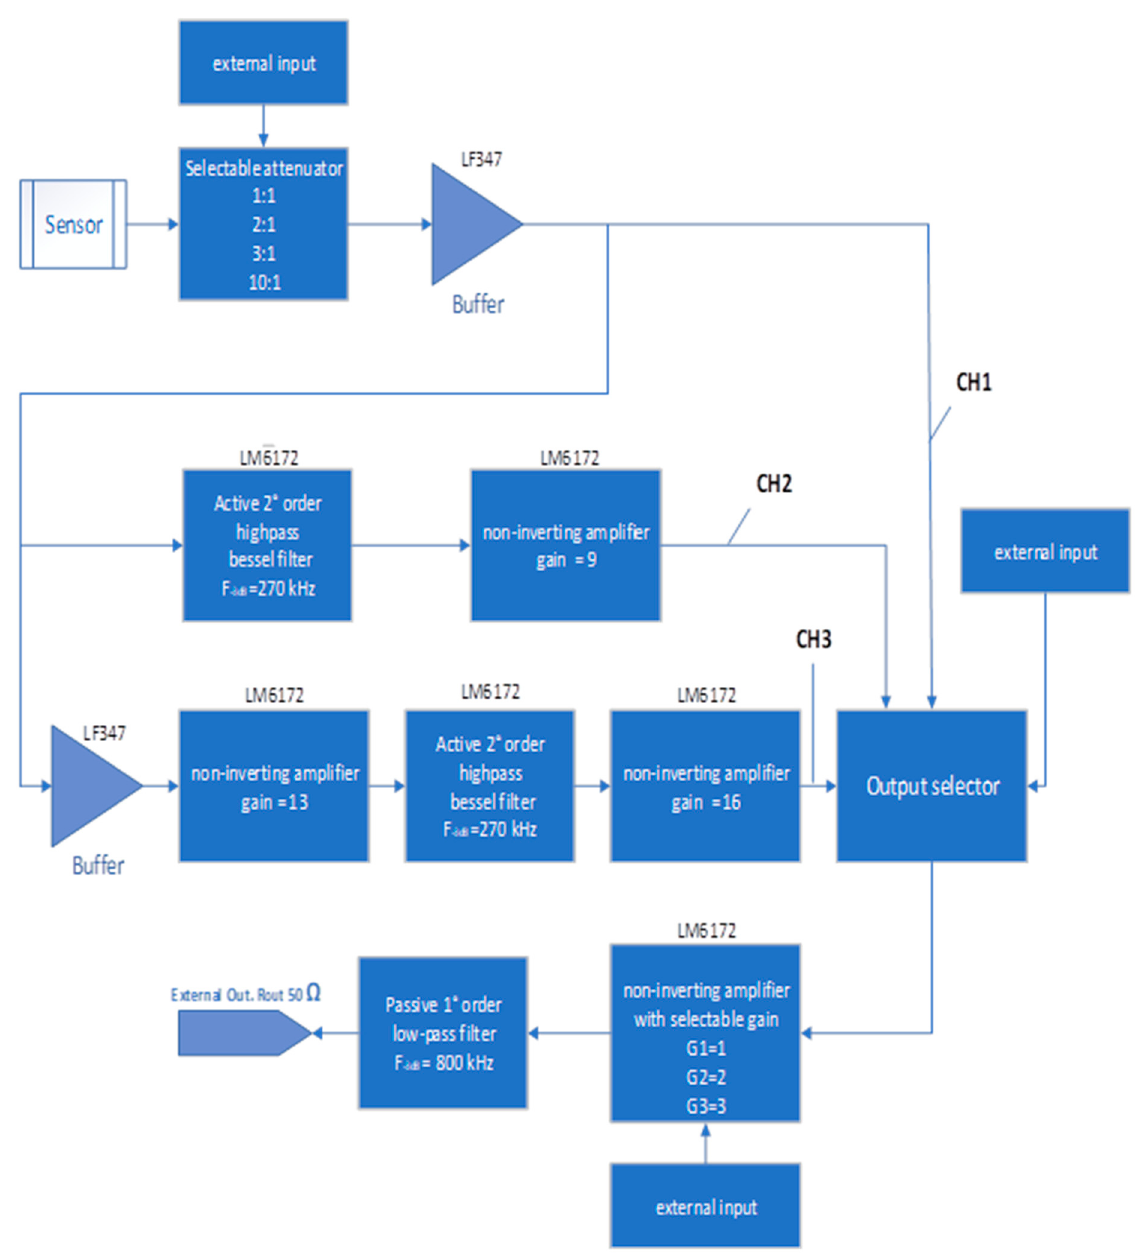
Figure 11. Block diagram of the multi-functional analog front-end. External inputs are digitally controlled from a central